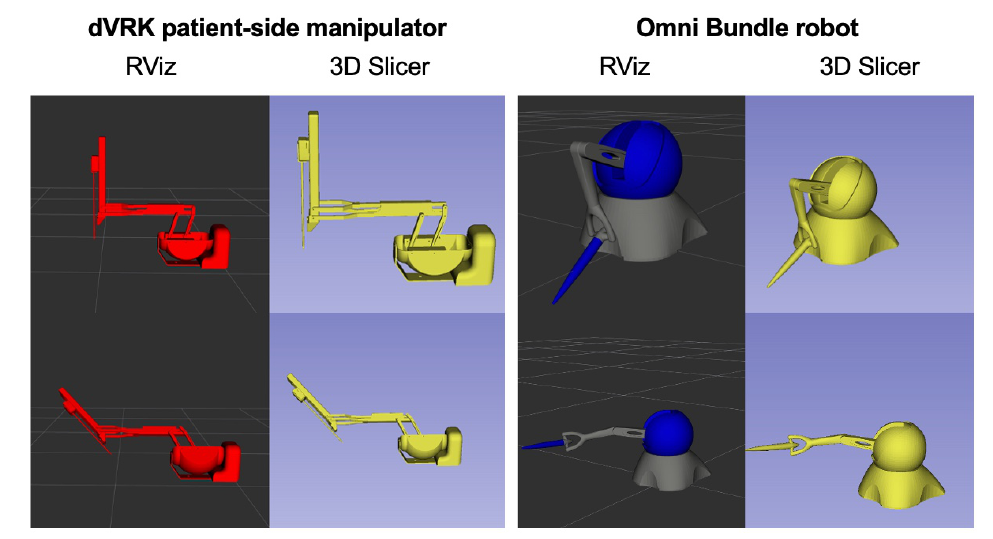
Figure 7. ( Left ) SlicerROS2 visualization of dVRK PSM1 in two different configurations. ( Right ) Slicer- ROS2 visualization of Omni Bundle robot in two different configurations. The viewer on the left is RViz, while the viewer on the right is 3D Slicer for both devices.